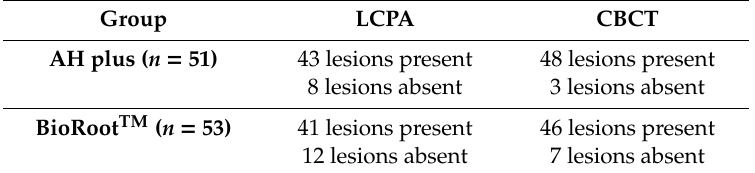
Table 2. Radiographic assessment (presence of lesions) of recalled teeth ( n = 125) at baseline. Group LCPA